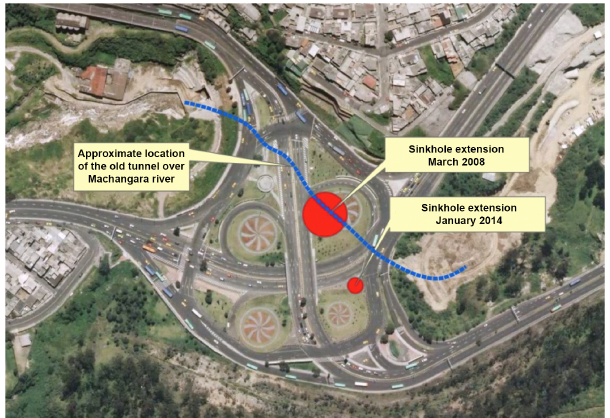
Figure 9. El Trébol sector with the flowing direction of the Machán- gara River including the sinkholes of 31 March 2008 (big red circle) and the recent but smaller one of 10 January 2014 (small red